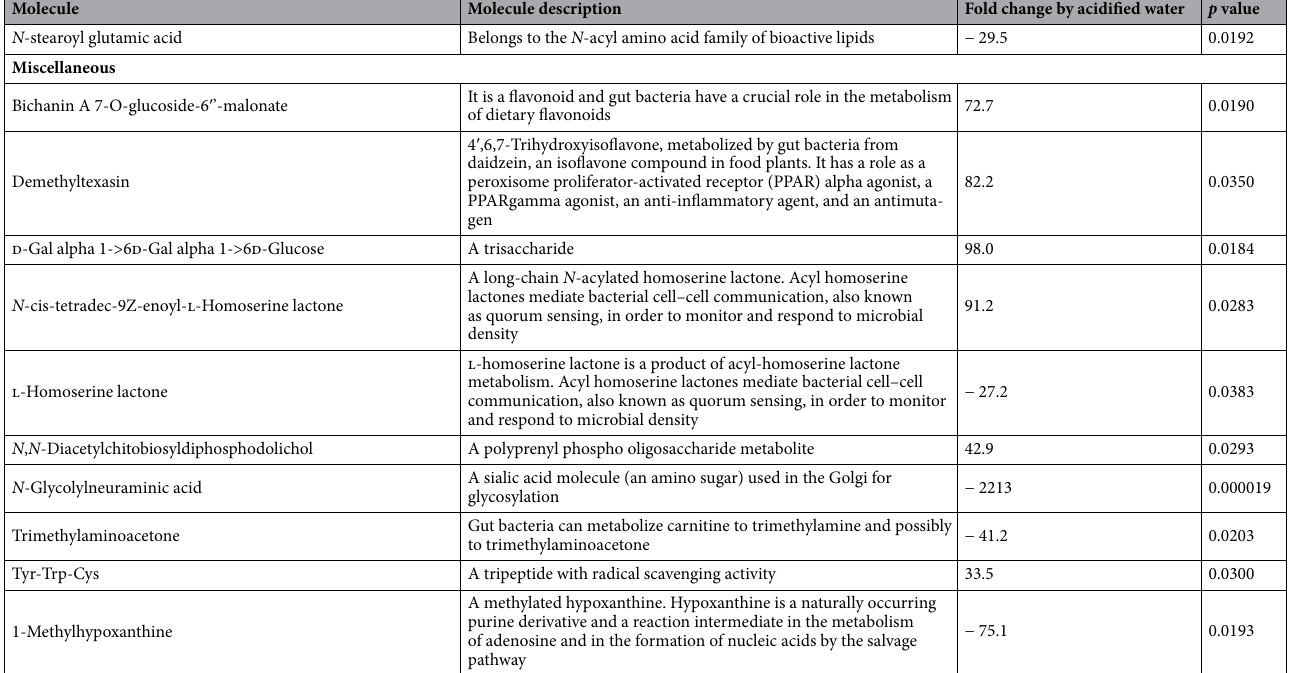
Table 2. HCl-acidified drinking water induced prominent changes in serum metabolite levels at 6 months of age (n = 6 mice). Molecule descriptions are from PubChem (https ://pubch em.ncbi.nlm.nih.gov/) and in the case of N -cis-tetradec-9Z-enoyl-l-Homoserine lactone and l-Homoserine lactone from Leadbetter and Greenberg 75 . P values were calculated using unpaired t-test with Benjamini–Hochberg correction for